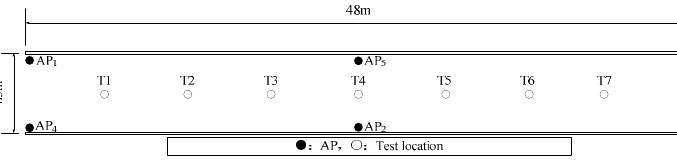
Figure 3. Plan of the undergrounds tunnel.